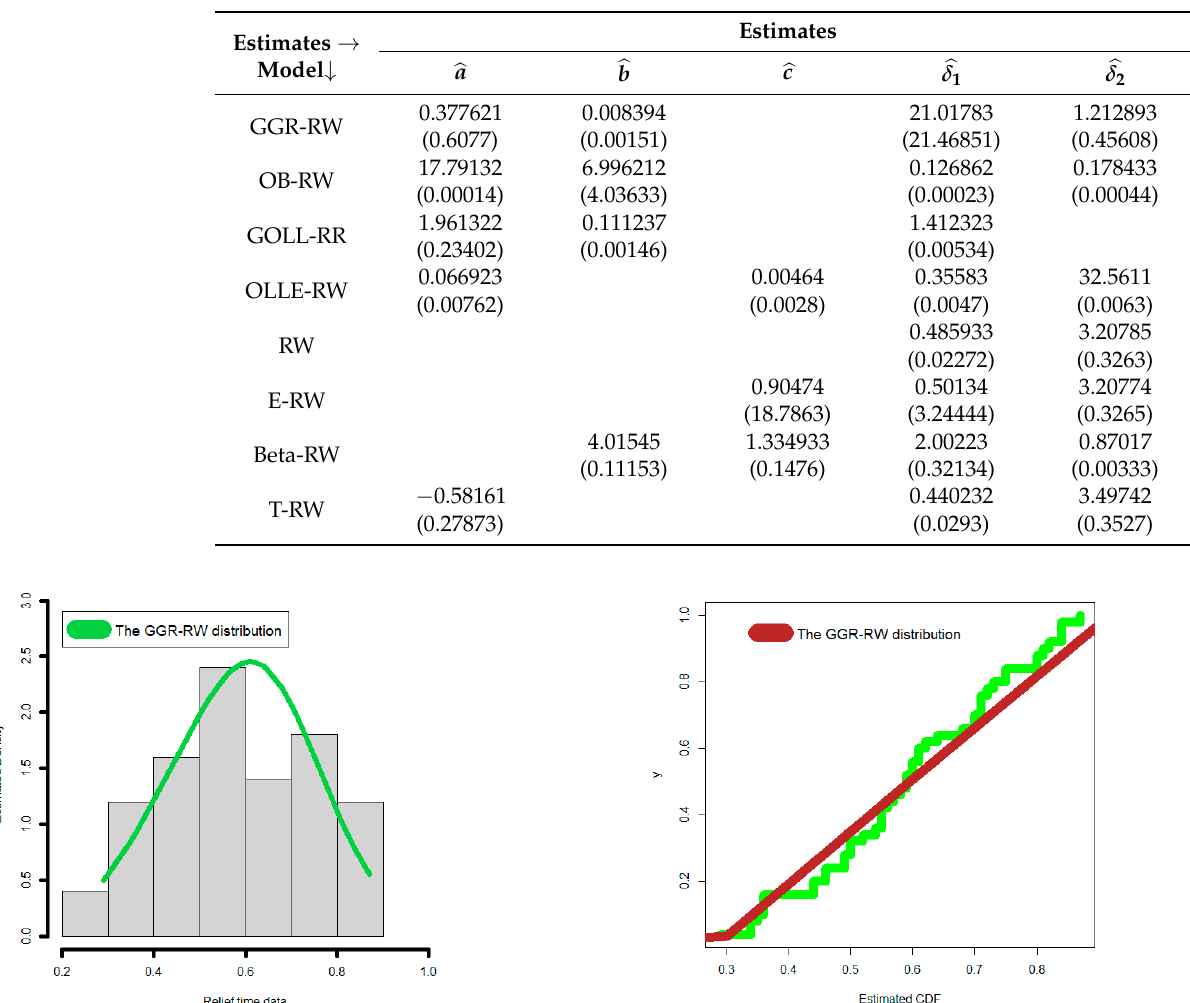
Table 7. MLEs and SEs for the relief times data.